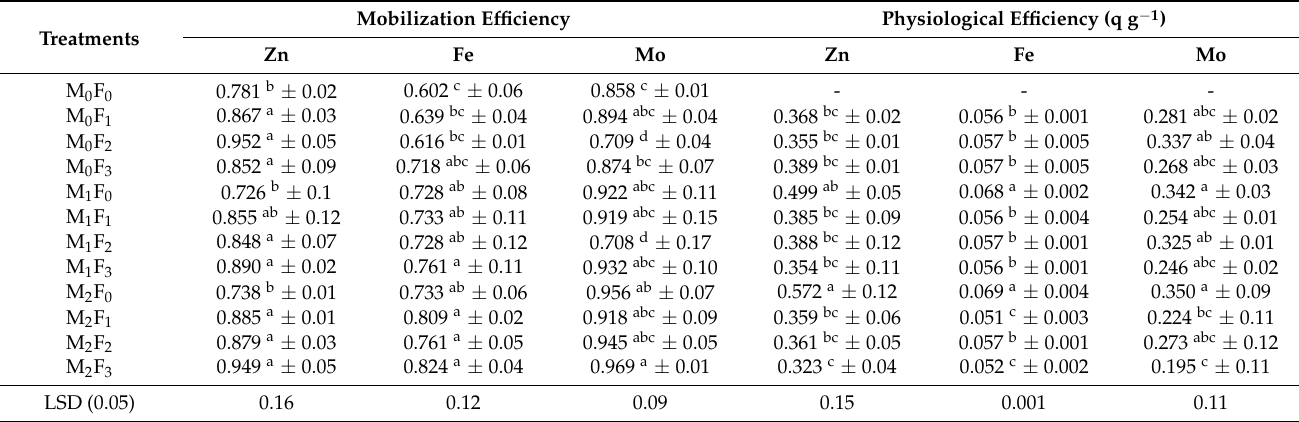
Table 6. Effect of the application of Zn, Fe and Mo molecules on micronutrient use efficiencies by